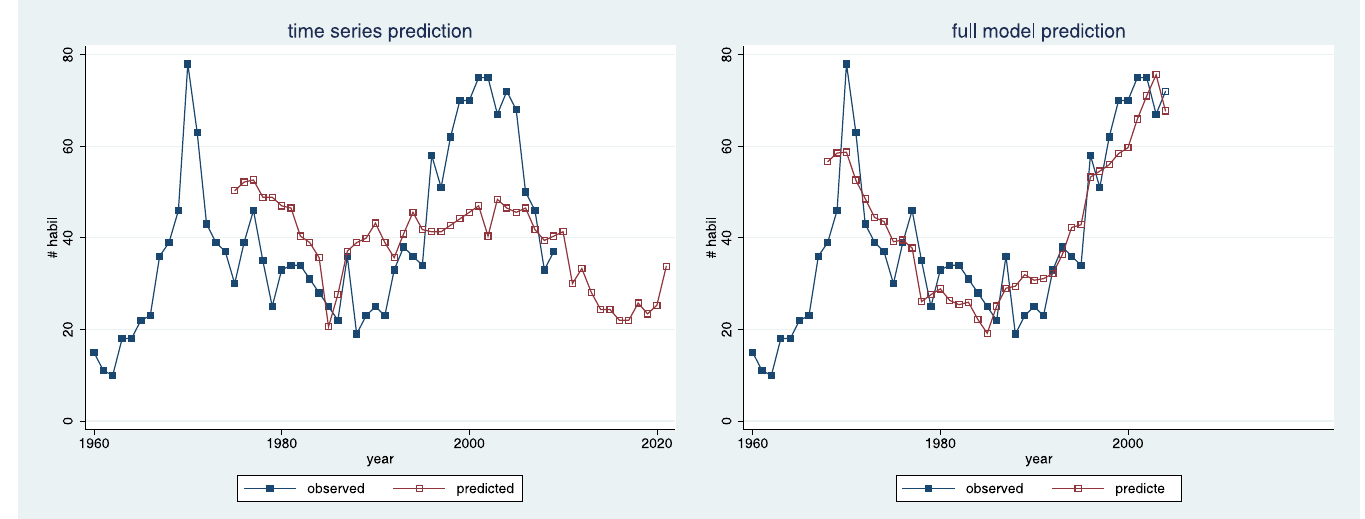
Fig 12. Out-of-sample Predictions. (A) Left panel is based on the best-performing model of Fig 4, i.e., on mere autocorrelation with a 15-year lag. (B) Right panel is based on final model, i.e., on model 1 of Table 5.